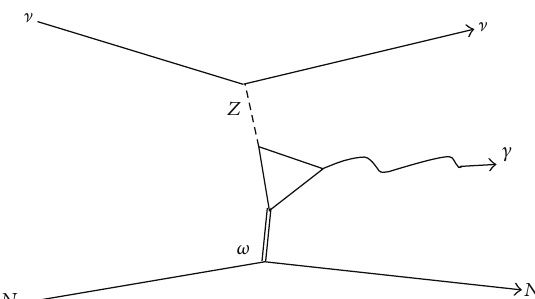
Figure 8: The triangular anomaly mediated photon production. The neutrinoneutralcurrentcouplesviaZ-boson,andthetargetnucleon or nucleus couples with a strong force mediated vector meson, such as an omega